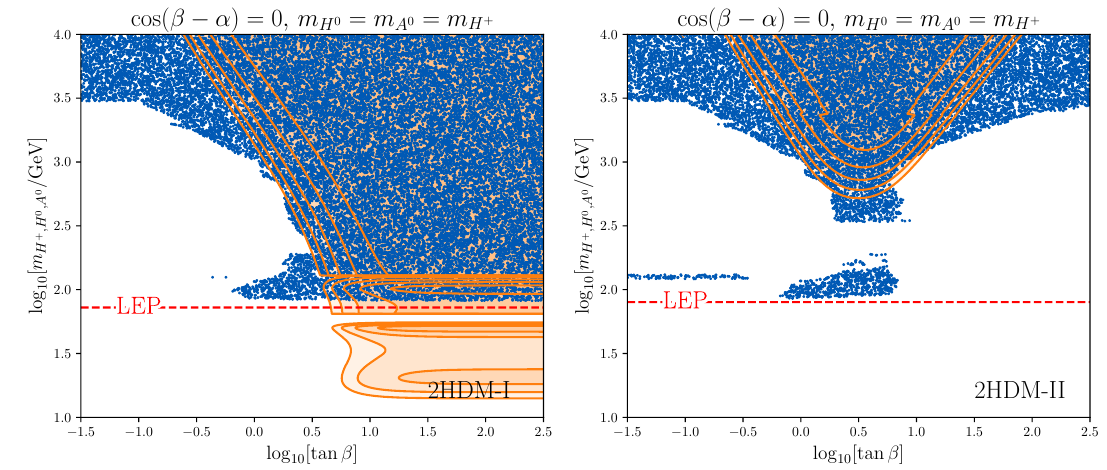
Figure 14 . Combined results from the global flavour fit and collider searches, with allowed points from collider searches in blue and contours from the flavour sector at 1,2,3,4,5 σ confidence, from darkest to lightest, with 2HDM-I results on the left and 2HDM-II on the